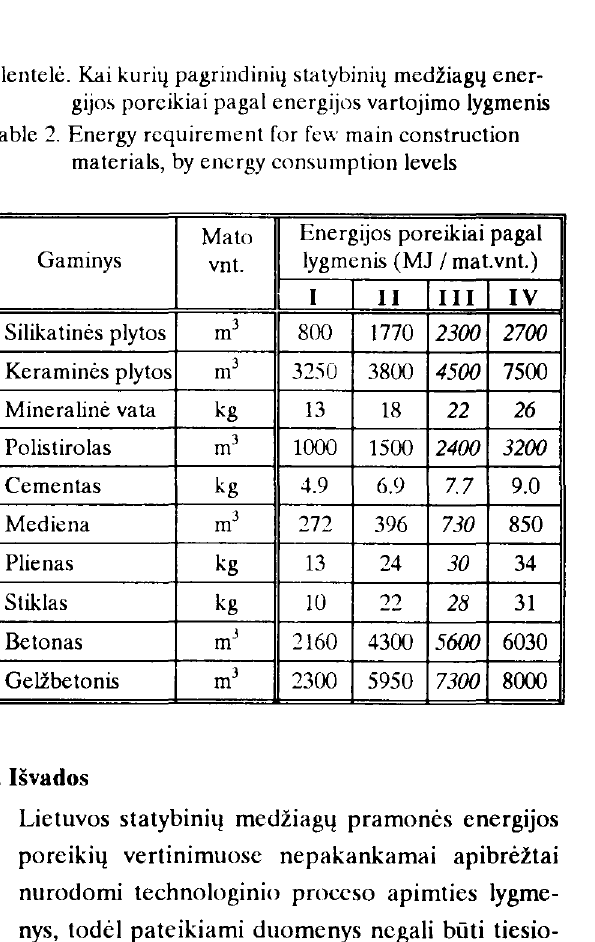
Table 2. Energy requirement for few main construction materials, by energy consumption levels